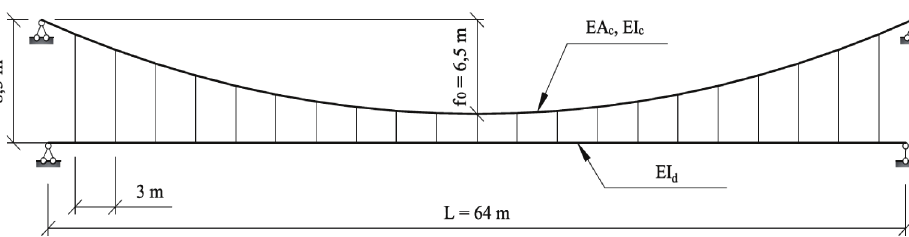
Fig. 2. Model for a single span suspension bridge